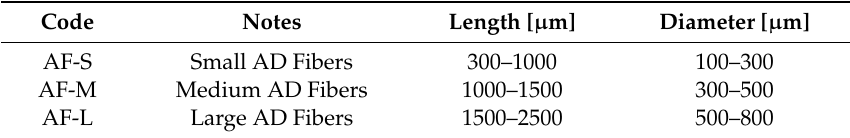
Table 1. Fibers’ size morphology, and geometry were evaluated by environmental scanning electron microscopy (ESEM, Quanta 450, FEI, Hillsboro, OR, USA). Table 1. Arundo donax fiber sample details.